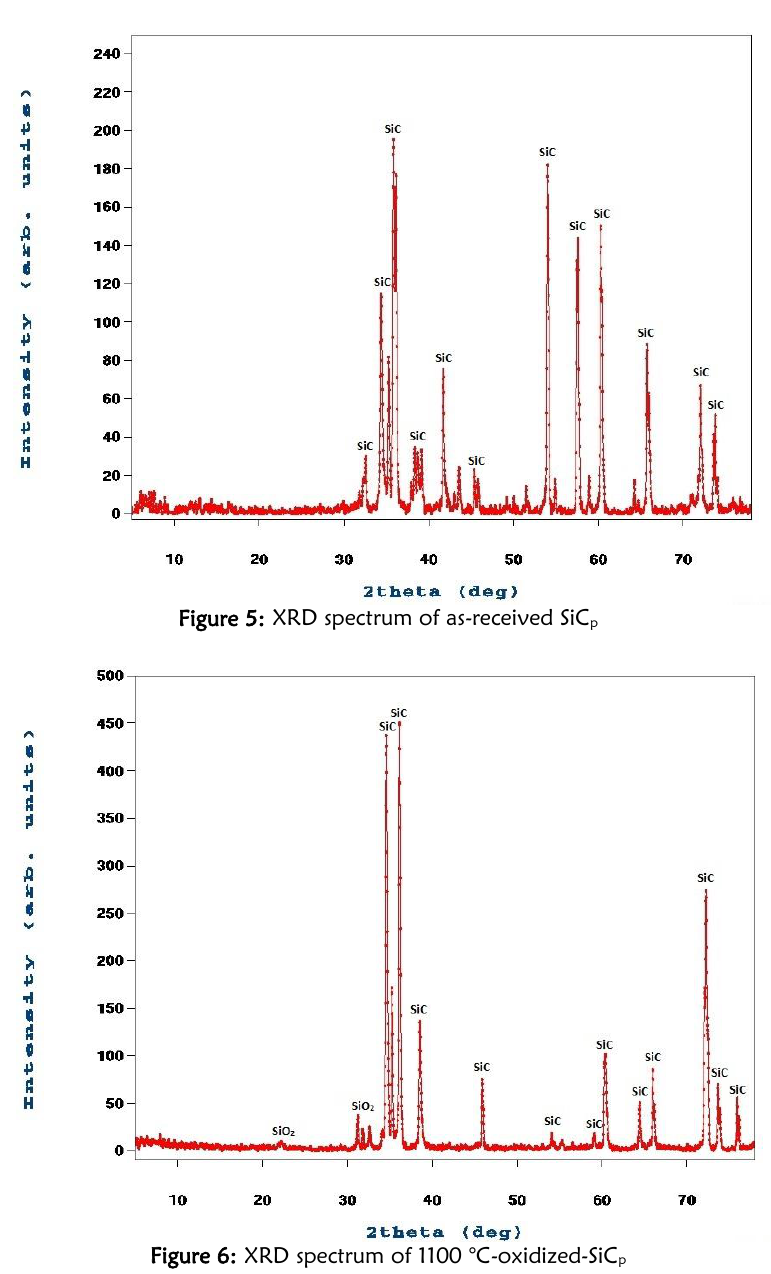
Figure 6: XRD spectrum of 1100 °C-oxidized-SiC